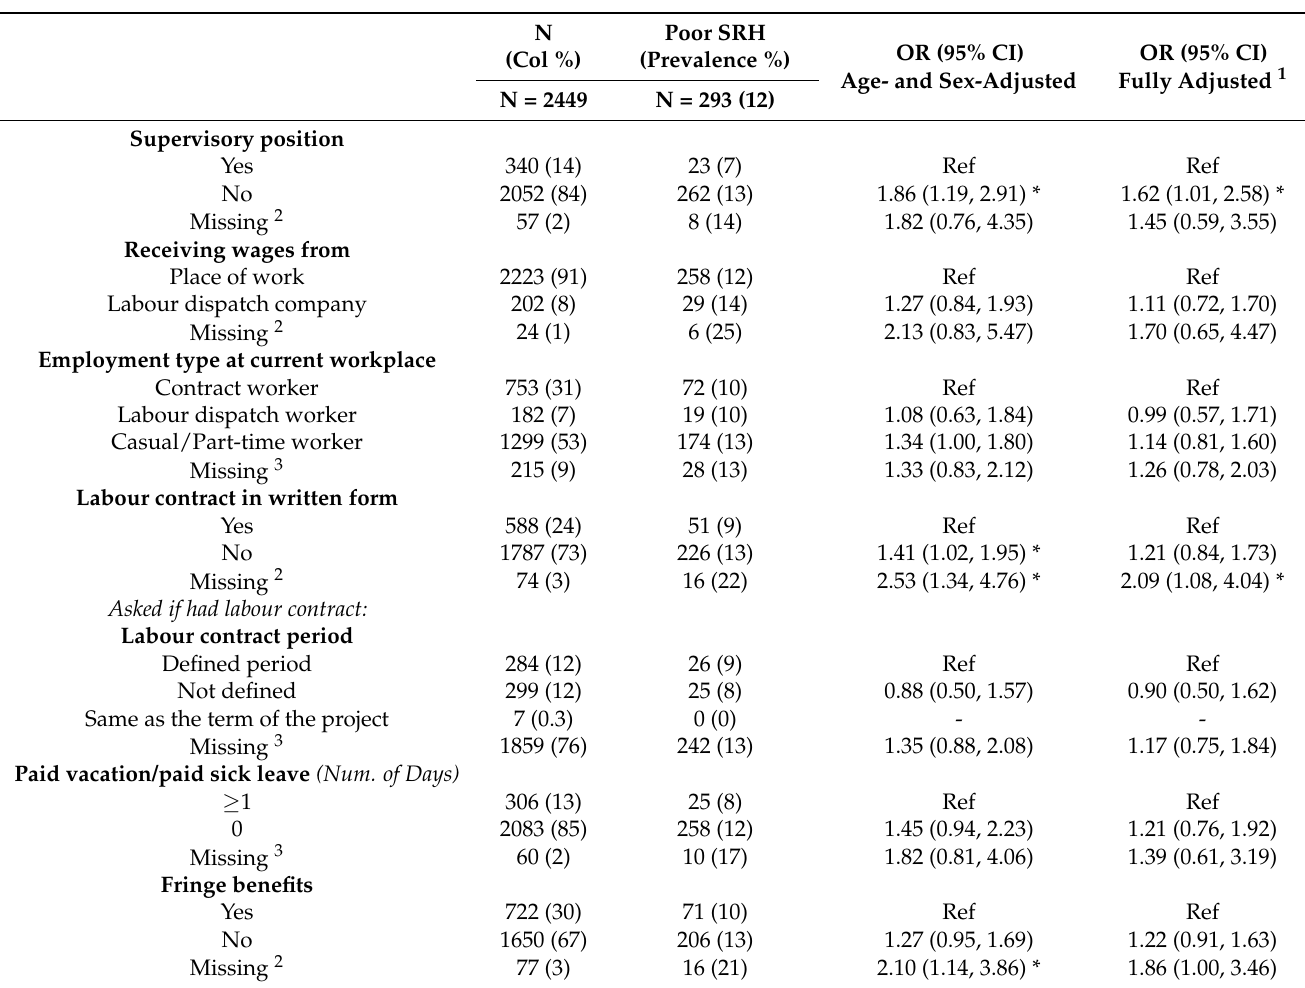
Table 3. Association between each labour-market characteristic and poor self-rated health among Chinese employees. N Poor (Col %)